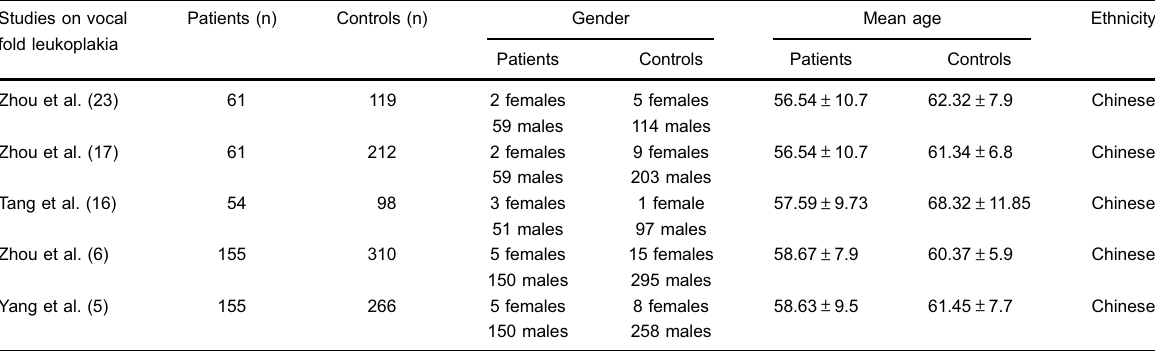
Table 1. Pro fi le of patients and